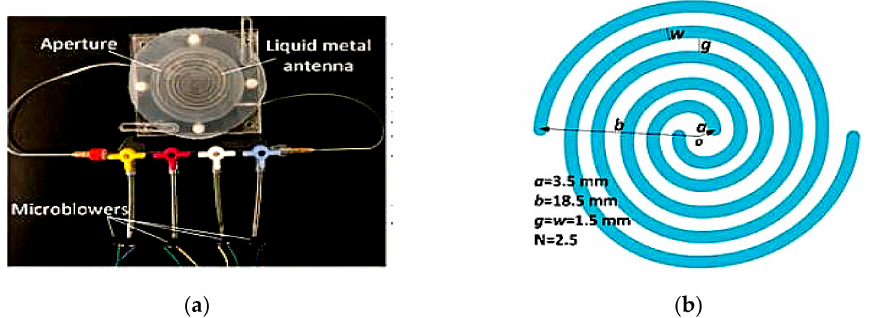
Figure 25. ( a ) The directivity-reconfigurable wideband antenna assembly. ( b ) Design parameters of the two-arm spiral antenna [16].